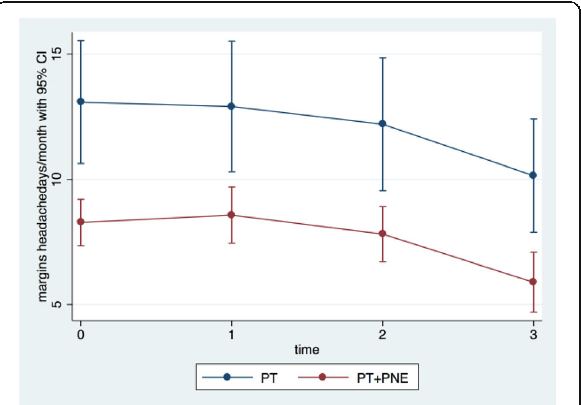
Fig. 1 (abstract P130). See text for description.